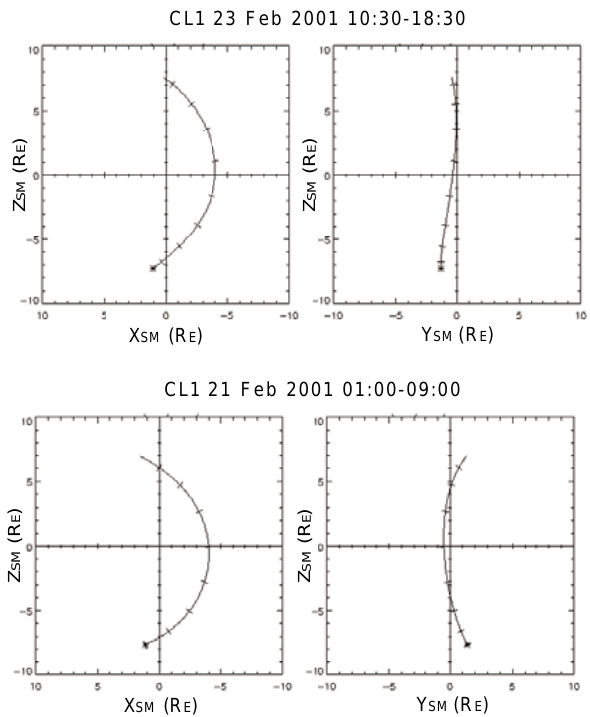
Fig. 3. Cluster 1 orbit plots in solar magnetospheric coordinates for perigee passes on 23 February (top) and 21 February (bottom) 2001. The Cluster satellites approach perigee through the southern polar cap, pass through the equatorial plane near midnight, and exit to the north. The 8-h orbit plots begin at the asterisk, with tics placed at each UT hour, on the